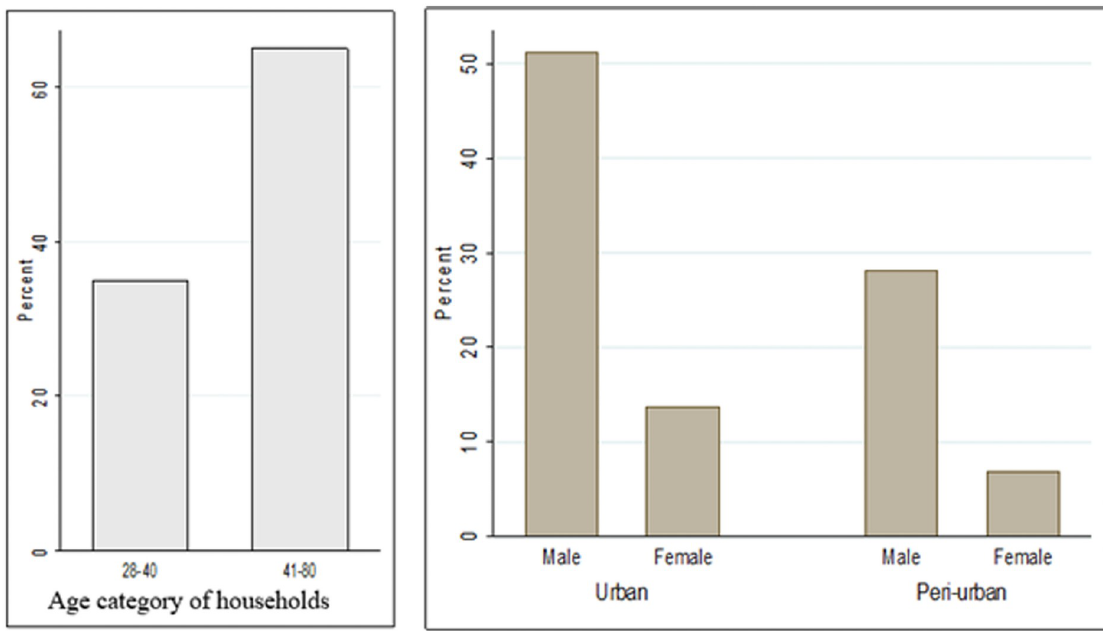
Fig 1. The household characteristics of farmers and their distribution in the study